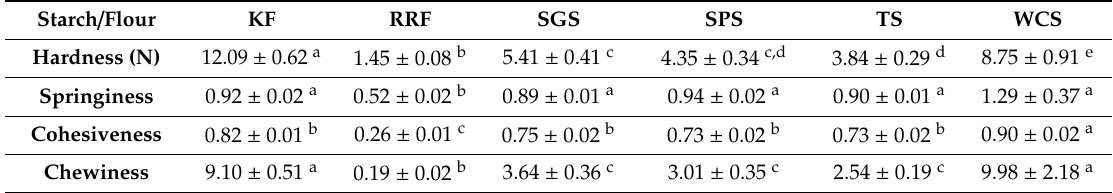
Table 6. The textural properties of the starch and flour gels (10% w / w in water). Values with the same alphabet superscript (a–e) in the same row are not significantly di ff erent.